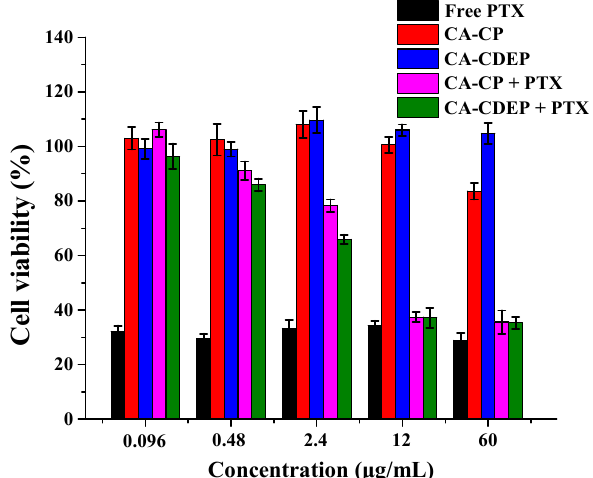
Figure 7. Cytotoxicity assay of the polymer blank micelles and drug-loaded micelles after 48 h incubation at different concentrations of polymer against NIH-3T3 cells using CCK-8 assay.